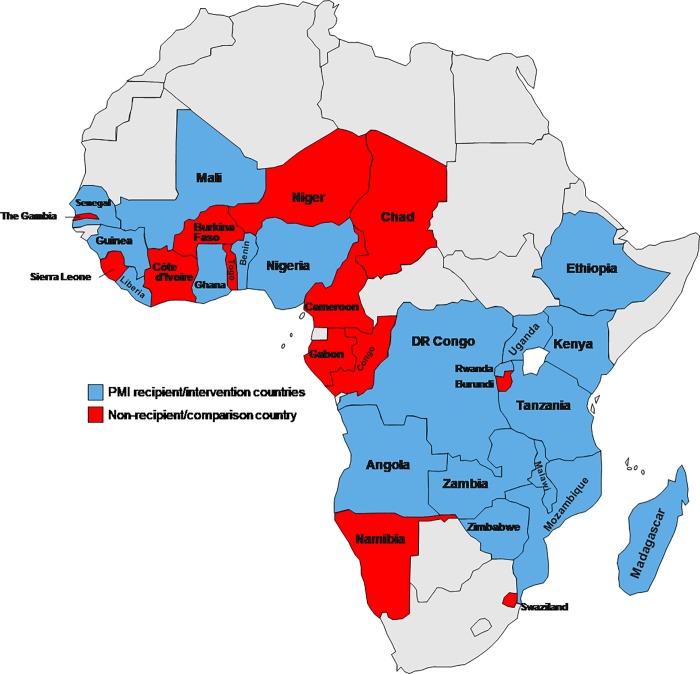
Geographical distribution of countries included in the study.PMI recipient/intervention countries (Year start): Angola (2006), Uganda (2006), Republic of Tanzania (2006),Malawi (2007), Mozambique (2007), Rwanda (2007), Senegal (2007), Benin (2008), Ethiopia (2008), Ghana (2008), Kenya (2008), Liberia (2008), Madagascar (2008), Mali (2008), Zambia (2008), Democratic Republic of the Congo (2011), Guinea (2011), Nigeria (2011), Zimbabwe (2011).